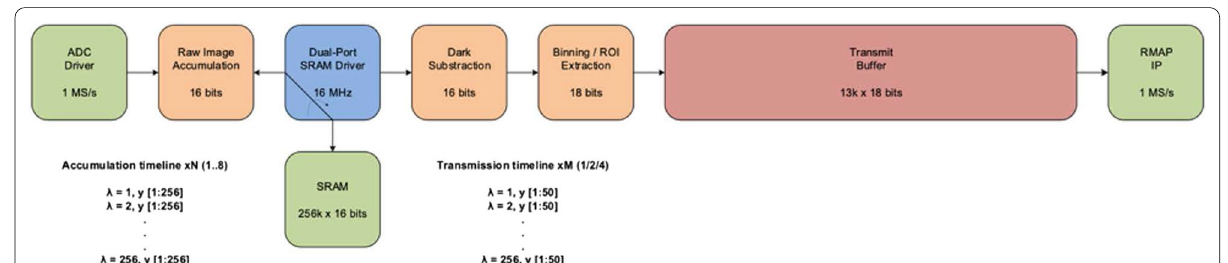
Fig. 17 Digital electronics detailed